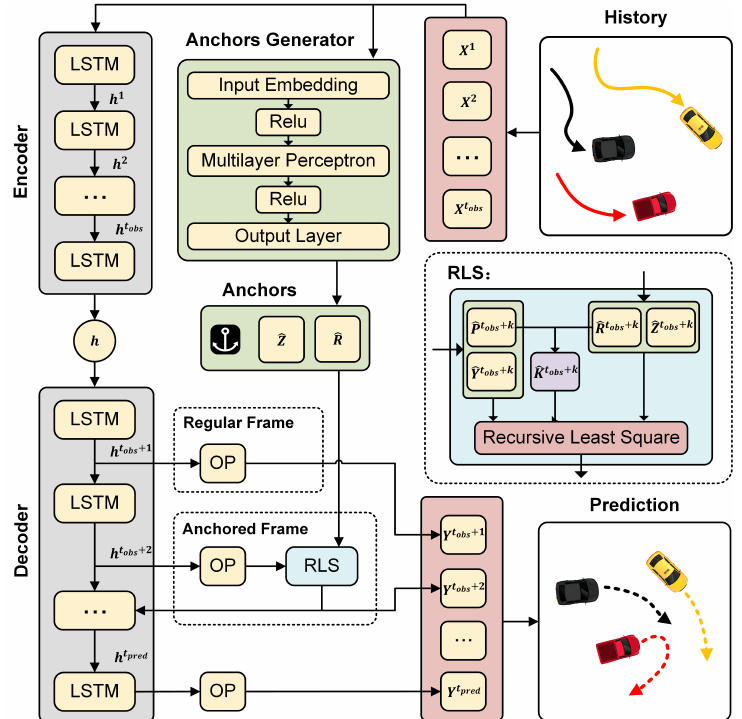
Figure 2. The pipeline of RRN. X denotes the history trajectories of vehicles. ˆ Y and ˆ P denote the mean and covariance characterizing the probability distribution over predicted trajectories. ˆ Z and ˆ R denote the mean and covariance characterizing the probability distribution over anchors. K denotes the gain matrix of RLS module. ’OP’ denotes the output layer of decoder. Trajectory encoder and decoder are both implemented by a couple of LSTM units. A bunch of anchors are generated from a global perspective. At several time steps, the rollout estimation is refined by RLS using information provided by anchors. ’Regular frame’ refers to the frame without anchor adjustment, while ’Anchored frame’ refers to the one with